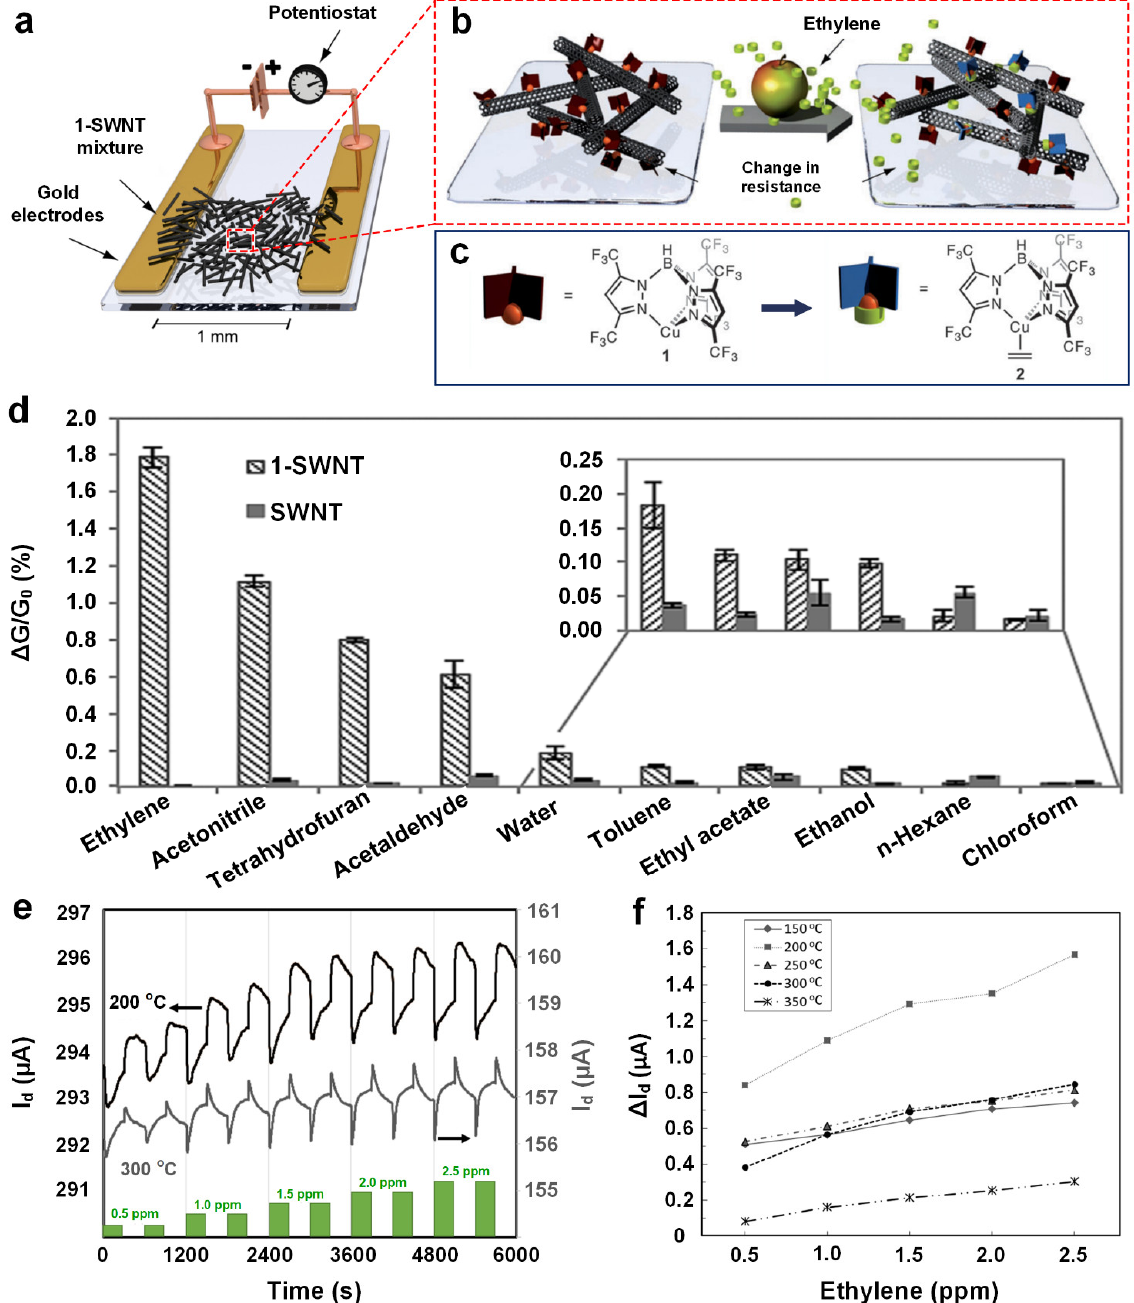
Figure 7. ( a ) Schematics of the Cu(I)-complex-based SWCNT-FET ethylene gas sensor. ( b ) The sens- ing process and ( c ) the corresponding molecular formulas of the Cu(I) and Cu(II) complex. ( d ) The sensor response towards a wide range of other organic compounds. Reproduced from Ref. [13] with permission from the Wiley-VCH GmbH. ( e ) Typical ethylene gas-sensing dynamic curves of Ir- gated SiC-FET sensor to different ethylene concentrations under 200 and 300 °C. ( f ) Plots of the response versus ethylene concentration at all tested temperatures (150–350 °C). Reproduced from Ref. [47] with permission from the IEEE.